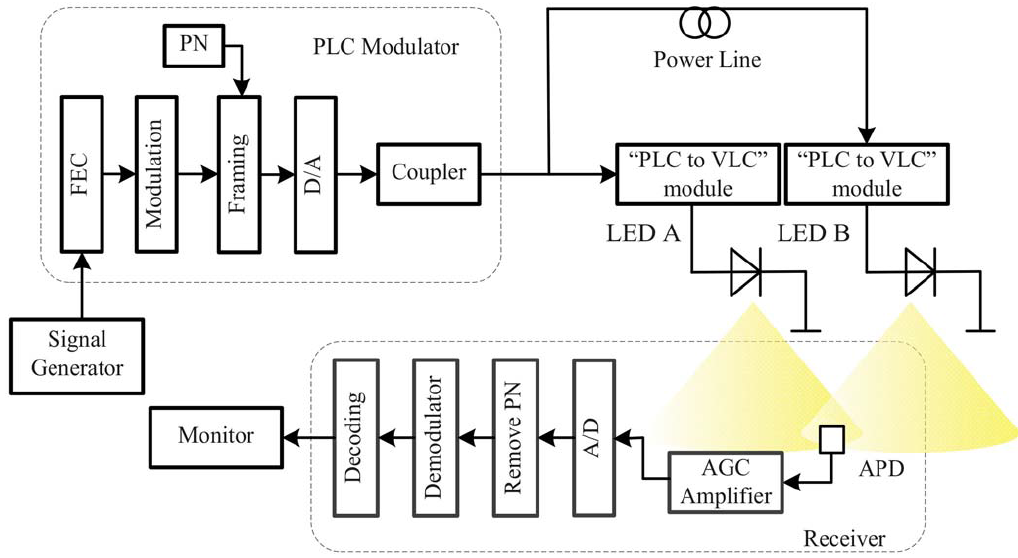
Figure 16. Block diagram of the integrated PLC and IWOC multicarrier system [15].